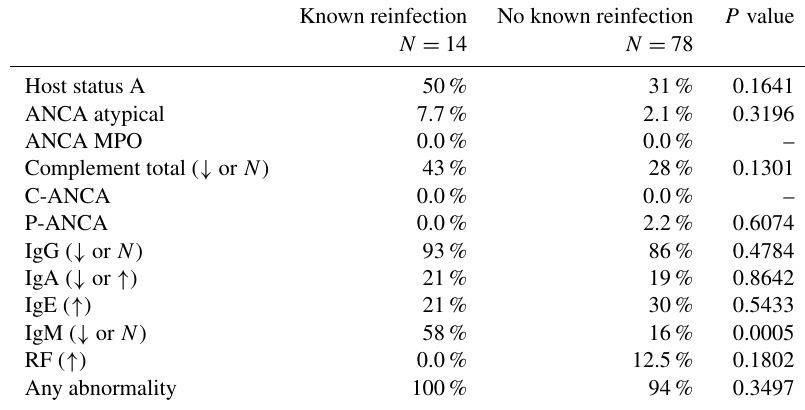
Table 4. Reinfection comparison of immunological laboratory assessments – clinically significant abnormalities